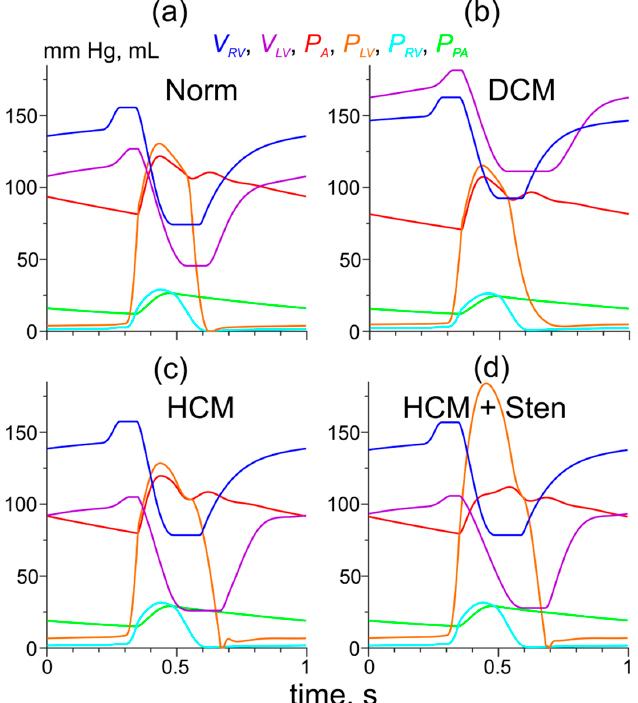
Figure 5. The results of simulations of hemodynamic variables during a heartbeat for the model of normal LV myocardium and normal LV geometry ( a ) and those with the DCM- and HCM-associated Tpm mutations and LV remodeling ( b , c , d ). ( b ) The cell level effects of the Asp230Asn TPM mutation were combined with LV dilatation as described in Methods; ( c ) the cell-level effects of the Ile284Val Tpm mutation were combined with LV hypertrophy as described in Methods; ( d ) the same as ( c ) plus the stenosis of the LV outflow tract. The color codes for the pressures and volumes are shown.